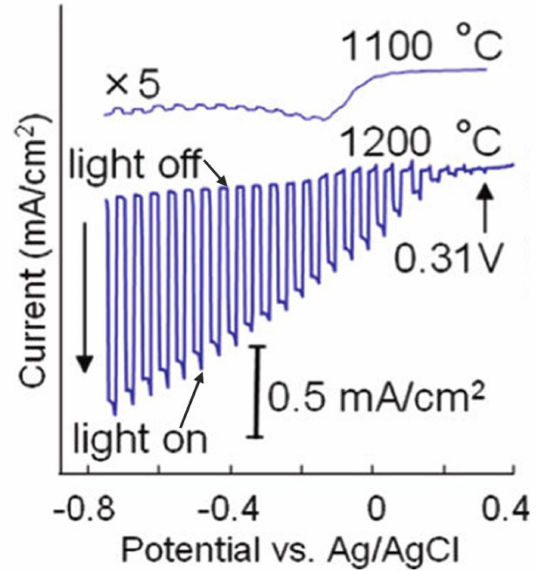
Figure 6. Current-potential curves in 0.1 M NaOH solution under chopped light illumination (500 W Xe lamp) for CaFe 2 O 4 electrodes treated at 1473 and 1373 K. Reproduced with permission from [86]. Copyright American Chemical Society,